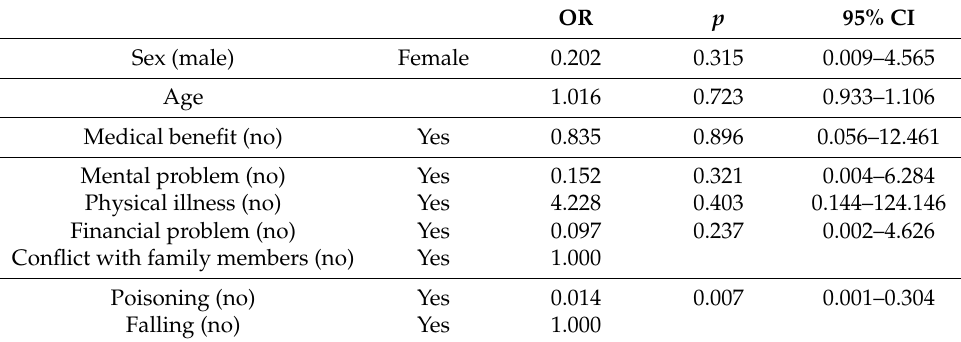
Table 4. Factors affecting the mortality of patients who performed self-harm in the hospital